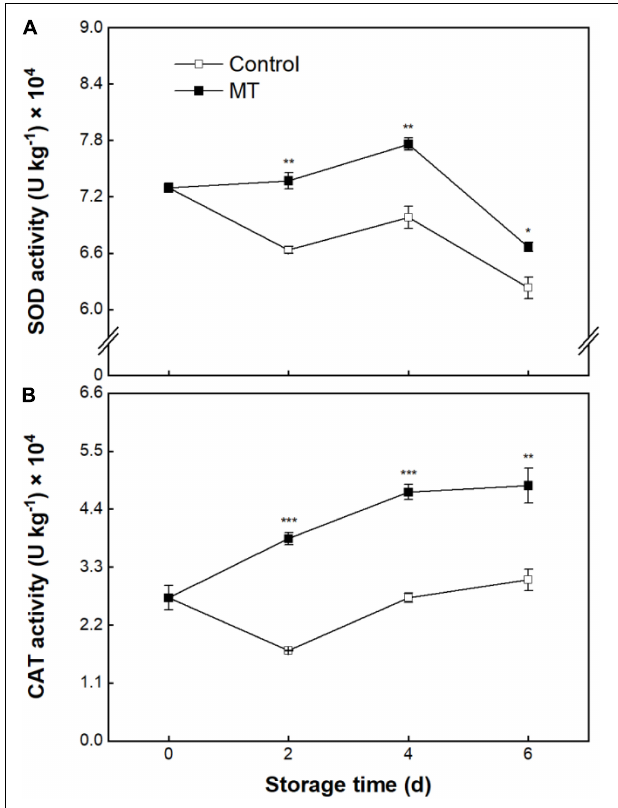
FIGURE 6 | Activities of superoxide dismutase (SOD) (A) and catalase (CAT) (B) in “Baoyan 7” rambutan fruit during storage at 25 ◦ C after treatment with 0.125 mmol L − 1 MT or water (control). The vertical lines represent the SE of triplicates while the asterisks indicate a significant difference between the MT group and the control group on the same day (* p < 0.05, ** p < 0.01, and *** p <